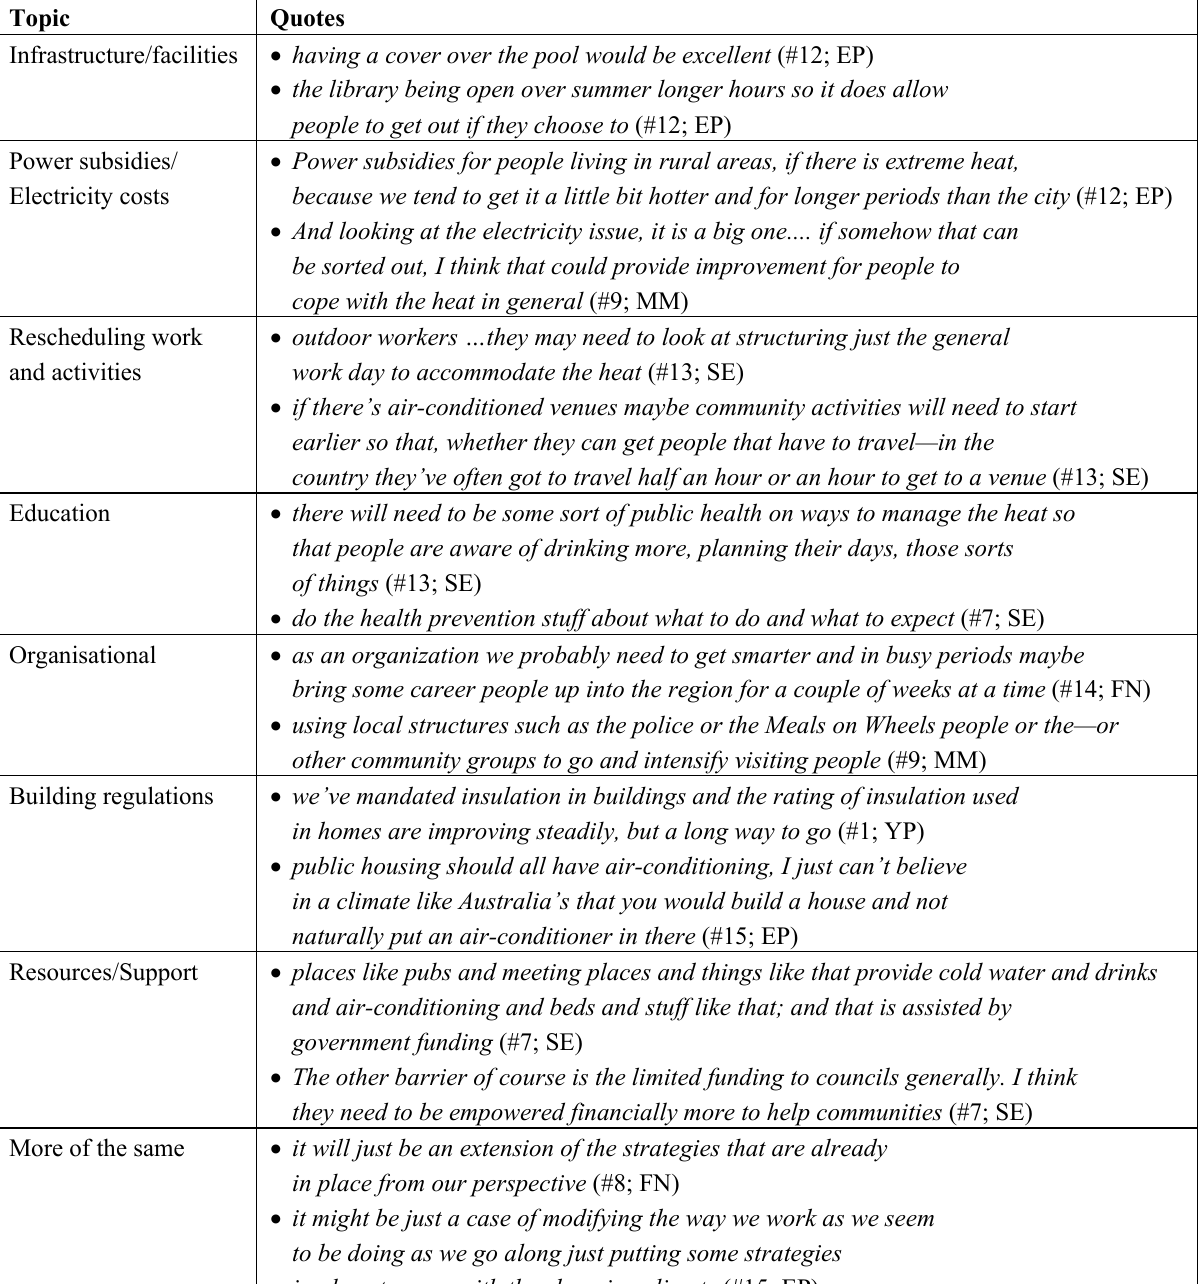
Table 3. Participant-suggested strategies for heat-adaptation with illustrative